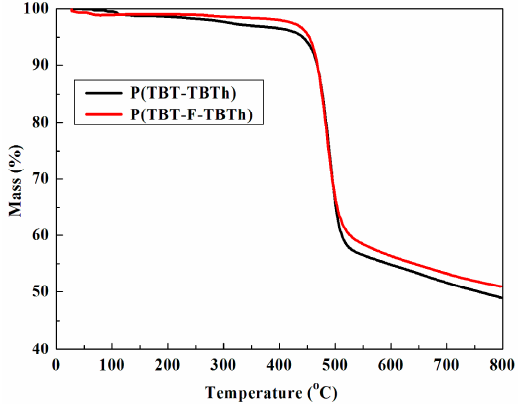
Figure 11. Thermogravimetric analysis (TGA) of P(TBT-TBTh) and P(TBT-F-TBTh).